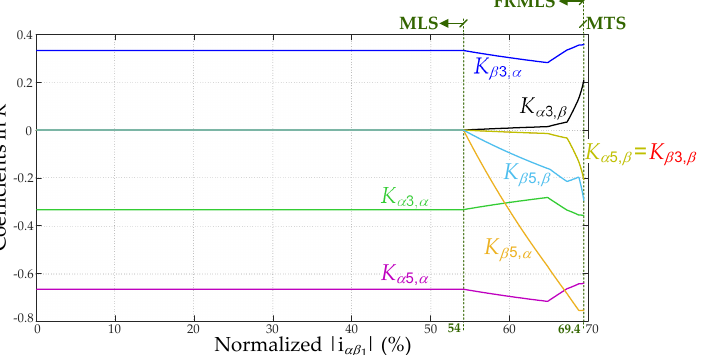
Figure 3. Coefficients in K [see (1)] for generating the VSD current references according to the FRMLS | (normalized by rated), for the scenario of OC in phase a of a six-phase machine as a function of | i αβ 1 with asymmetrical WSA, star connection, and single neutral point. The FRMLS coefficients match | = 69.4%. | < 54%, and those of MTS for | i those of MLS for | i αβ αβ 1 1